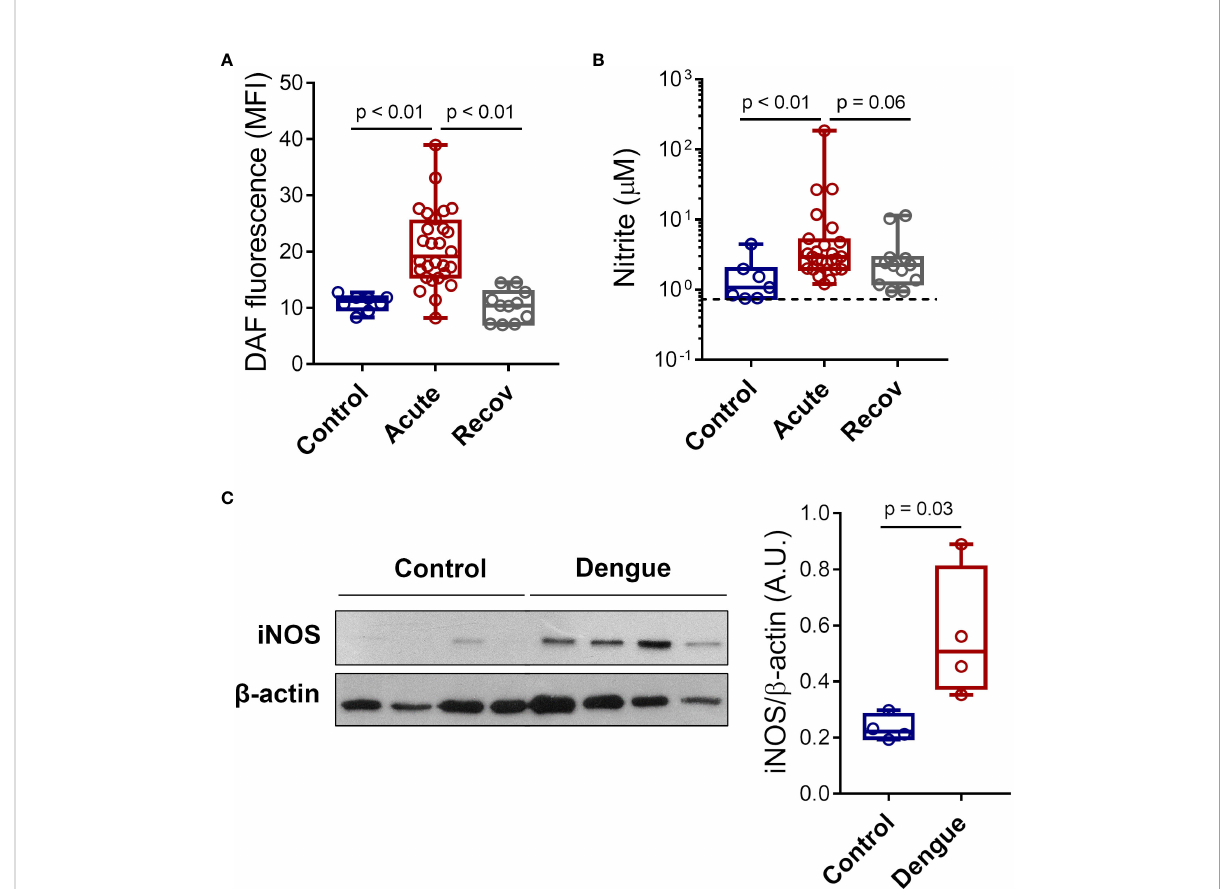
FIGURE 1 Dengue induces iNOS expression and NO synthesis in platelets. (A) The mean fl uorescence intensity (MFI) of DAF-FM diacetate fl uorescent probe indicating NO synthesis in platelets from 8 healthy volunteers (control), 28 patients with dengue at the acute phase, and 12 patients at the recovery phase. (B) Platelets from 7 healthy volunteers, 25 dengue-infected patients in the acute phase, and 12 patients in the recovery phase were isolated and incubated for 4 hours at 37°C and nitrite production was quanti fi ed in platelets supernatants by Griess reaction. The dotted line indicates the lower detection limit of the protocol. (C) Expression of iNOS in platelets lysates from 4 healthy volunteers and 4 dengue- infected patients was analyzed by western blot. b -actin was used as load control. Band densitometry of iNOS expression corrected by b -actin expression is shown (A.U., arbitrary units). Each dot represents one patient or healthy volunteer. The horizontal lines in the box plots represent the median, the box edges represent the interquartile ranges, and the whiskers indicate the minimal and maximal values in each